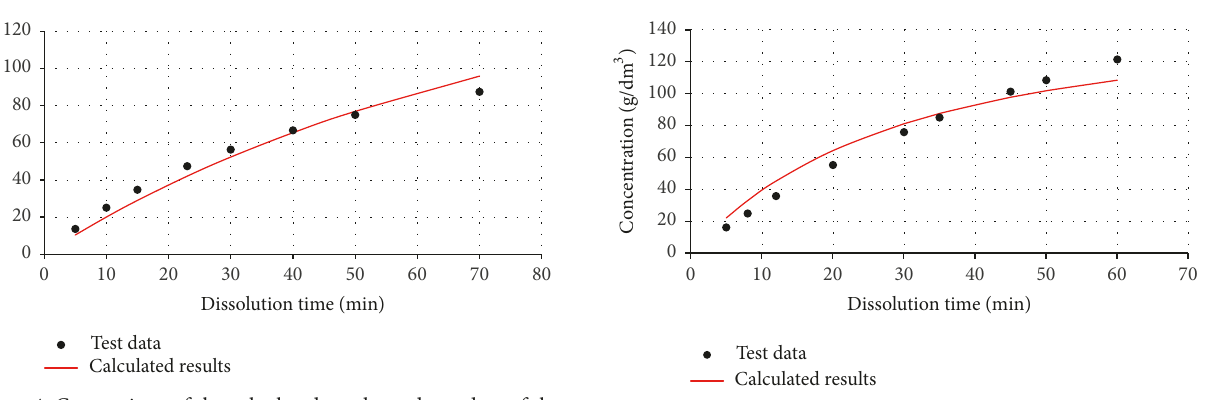
Figure 6: Comparison of the calculated results and test data of the transient dissolution of rock salt at 𝑄 = 9 cm 3 min −1 .